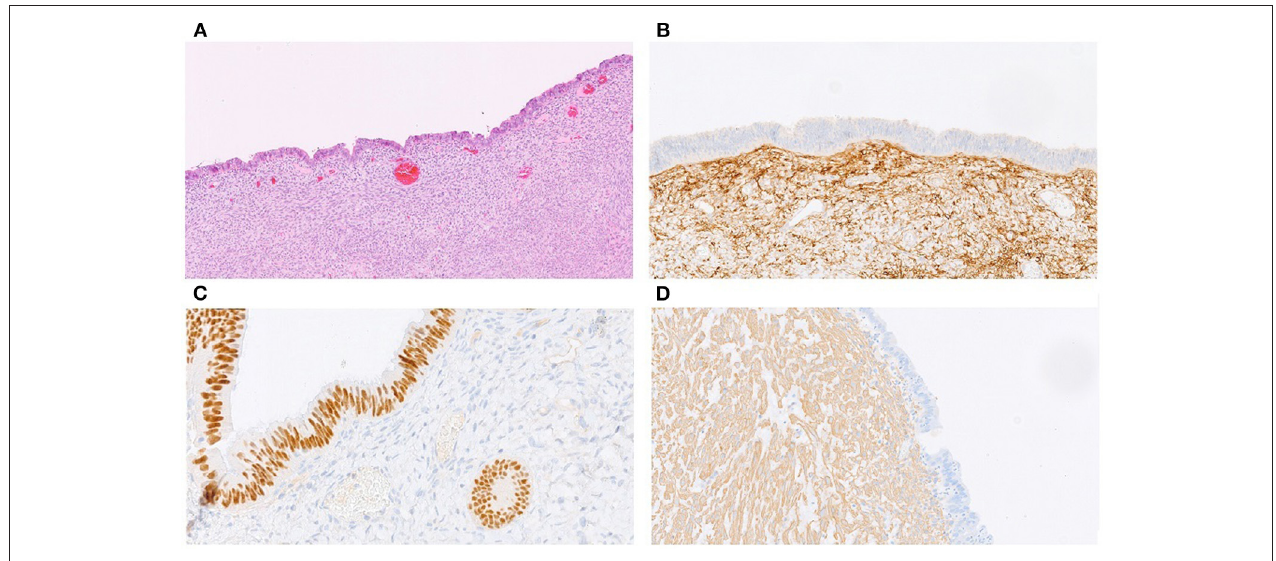
FIGURE 3 | Pathological findings: (A) H&E staining of the mass, showing a thick smooth muscle layer lined by endometrial epithelium and stroma (10x); (B) immunohistochemical analysis of CD10 showing a diffuse expression in the endometrial stroma without staining of the endometrial mucosa (20x); (C) PAX8 nuclear expression limited to the endometrial mucosa (40x); (D) smooth muscle actin (SMA) expression in the smooth muscle layer